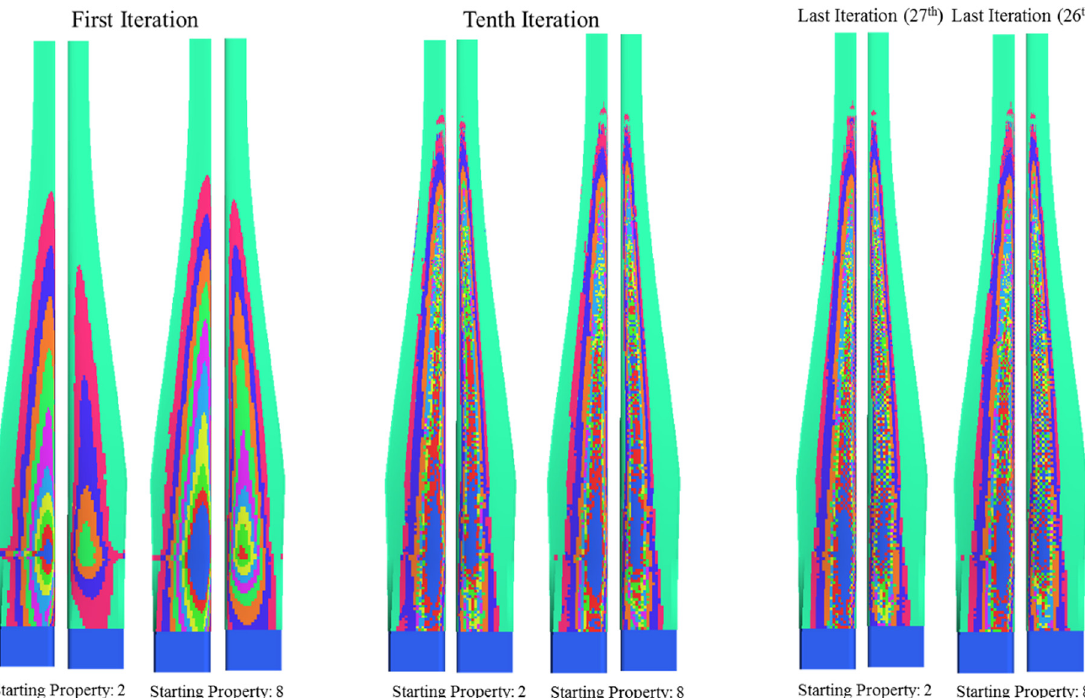
Fig. 5. Three stages of the Aerogenesis 5kW blade optimisation, with pressure surface on the left of each pair and suction surface on the